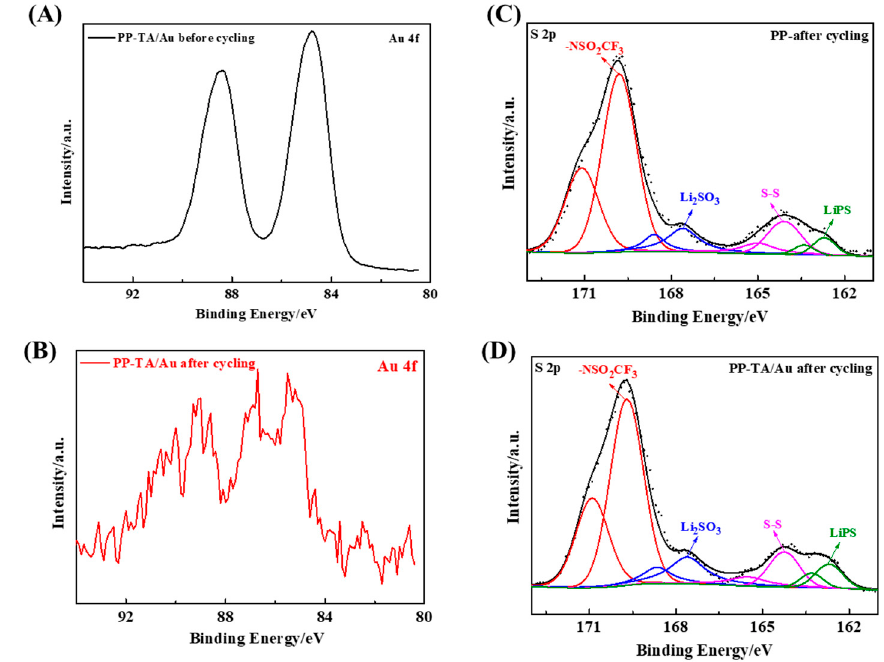
Figure 6. Au 4f spectra of PP-TA / Au separator ( A ) before and ( B ) after cycling in Li-S battery. S 2p spectra of PP-TA / Au separator ( C ) before and ( D ) after cycling in Li-S battery.